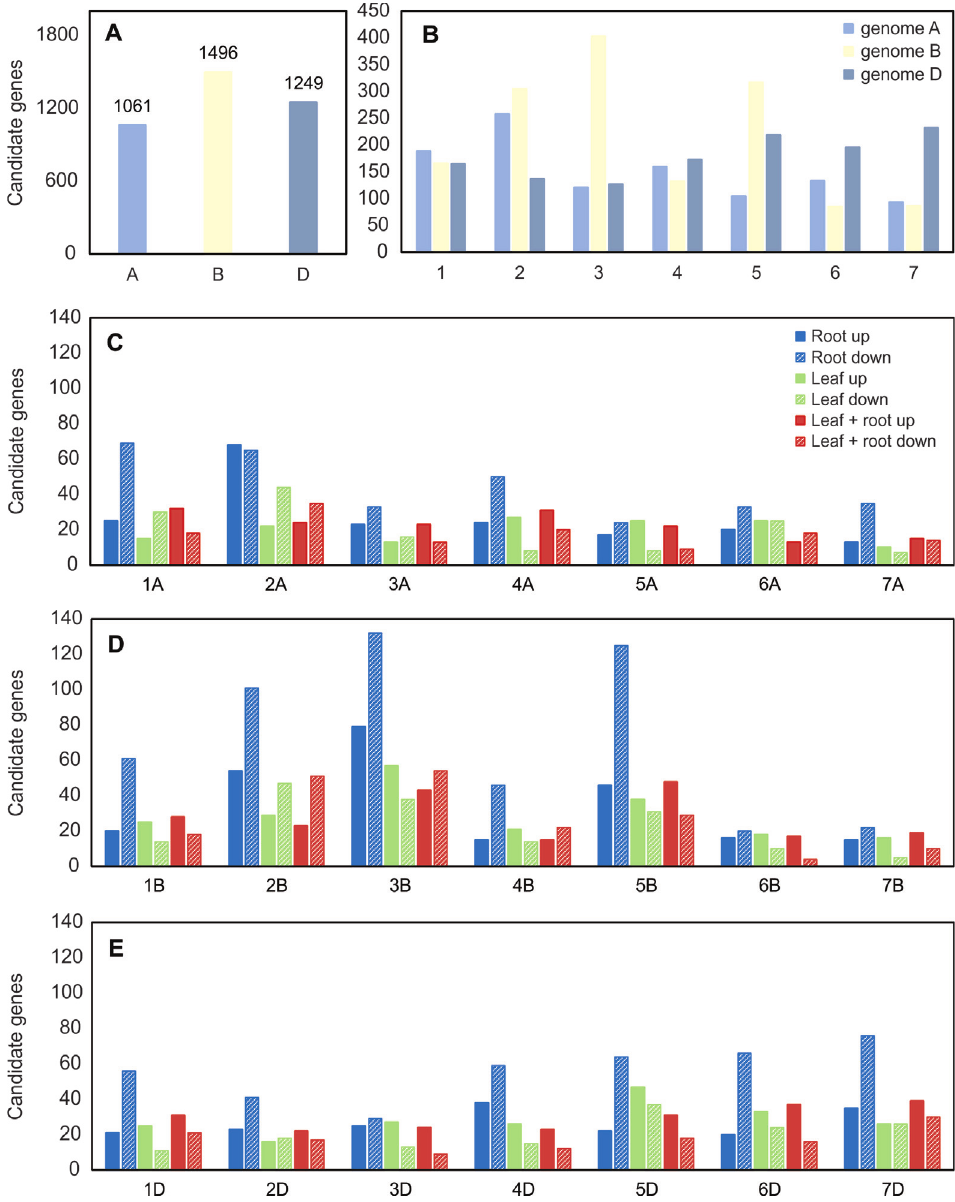
Figure 7 - Genome distribution of the candidate genes associated to drought response in the wheat cultivar MGS1 Aliança. Sequences were retrieved by BLAST against the Triticum aestivum cv. Chinese Spring genome at an E-value cutoff 1e-100. (A) Number of candidate genes per genome. (B) Total number of candidate genes per chromosome. (C), (D) and (E) Number of candidate genes that are up- or down-regulated and that are specific to roots, leaves, in common between both tissues for genome A, B and D,